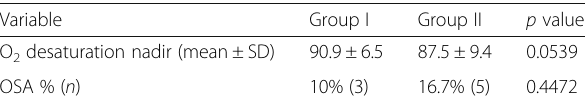
Table 2 Comparison between both groups regarding patients having OSA Variable